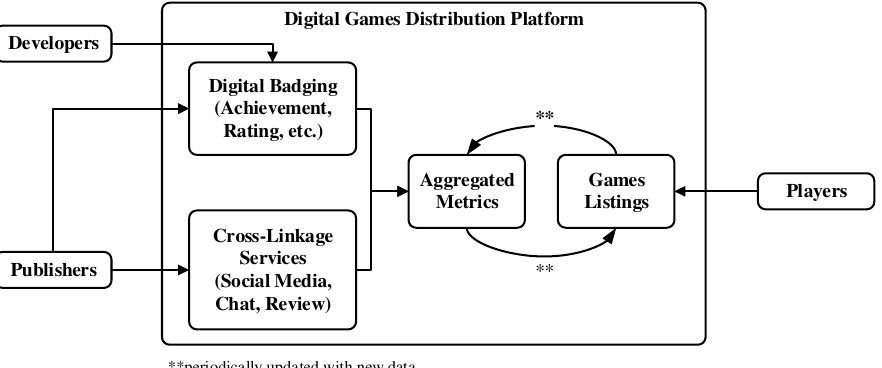
Figure 13. An envisioned “experience-driven” business